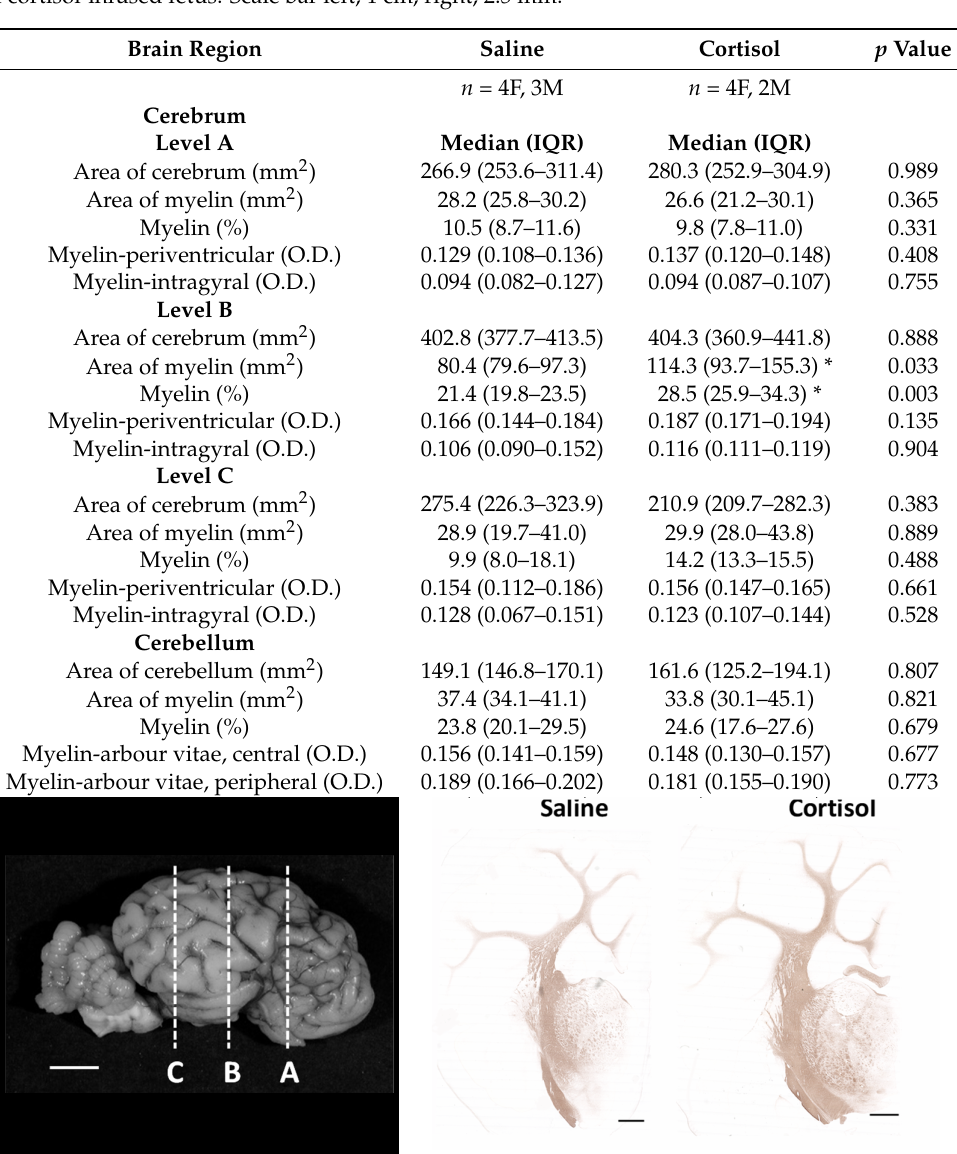
Table 3. Morphology of the brain. Data are presented as median (interquartile range, IQR, 25th– 75th percentile) from saline ( n = 7) and cortisol-infused ( n = 6) fetuses at ~130 days of gestational age (dGA). * Significantly different from saline control, p < 0.05, Mann–Whitney nonparametric test (area of cerebrum, level C) or t -test (remaining variables). Below table, left: representative images showing the level (A, B and C) at which the brain regions were sectioned and stained with myelin basic protein (MBP); right: MBP-positive immunostaining of the cerebrum (level B) from a saline and a cortisol-infused fetus. Scale bar left, 1 cm; right, 2.5